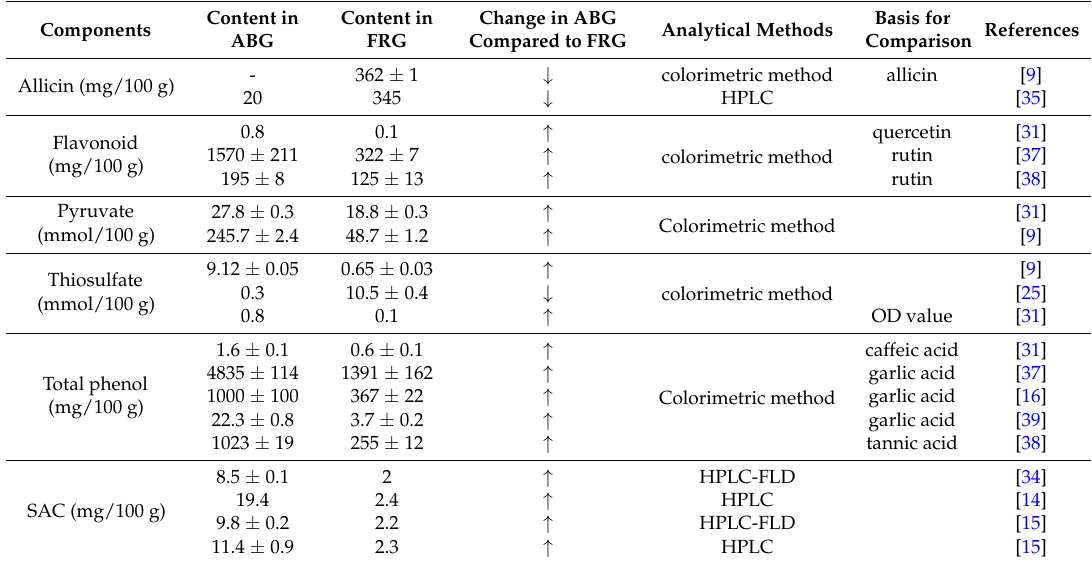
Table 2. Comparison of contents of phytochemical components between ABG and FRG.